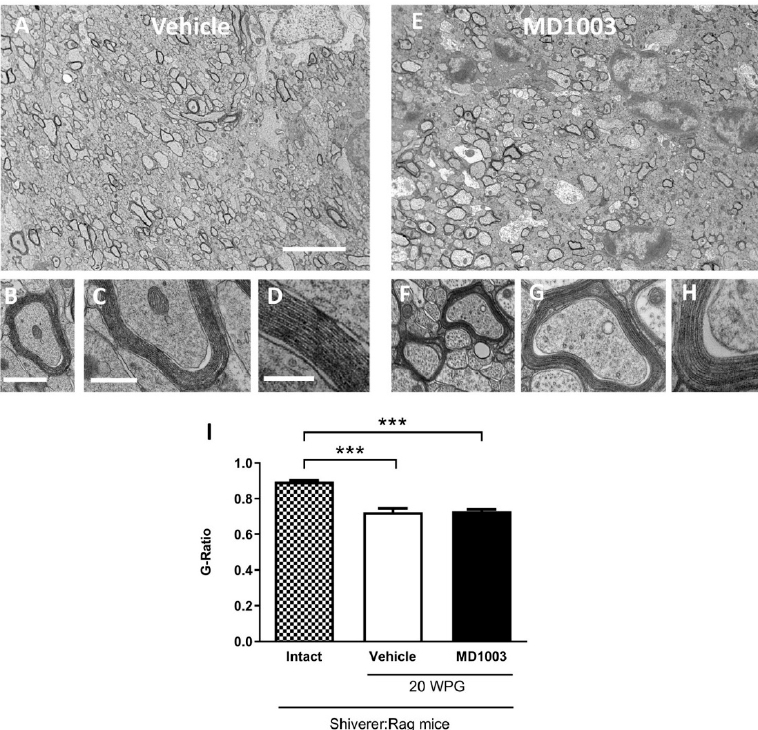
Figure 7. MD1003 does not affect the g-ratio of the human graft-derived myelin. Ultrastructure of graft-derived myelin in sagittal sections of the core of the corpus callosum of shiverer mice at 20 wpg and with vehicle ( A – D ) and MD1003 ( E – H ) treatments. ( A , E ) General views illustrating the presence of some donor-derived electron dense myelin. ( B , D , F – H ) Higher magnifications of axons ensheathed by donor-derived myelin for vehicle- and MD1003-treated groups validate that host axons are surrounded by thick and compact donor-derived myelin. Enlargements in ( D , H ), show the presence of the major dense line validating the presence of donor wild-type myelin. No difference in compaction and structure is observed between the myelin of human cells in vehicle-and MD1003- treated mice. ( I ) Quantification of g-ratio revealed significant differences between the graft-derived myelin and intact (not treated and not grafted) shiverer myelin. No significant difference between myelin thickness of axons myelinated by grafted cells in vehicle vs. MD1003. Two-way ANOVA followed by Tukey’s multiple comparison test ( n = 3–4 mice per group). WPG: week post-graft. *** p < 0.001. Error bars represent SEMs. Scale bars in ( A , E ): 5 µ m, in ( B , F ): 1 µ m, in ( C , G ): 500 nm, in ( D , H ): 200